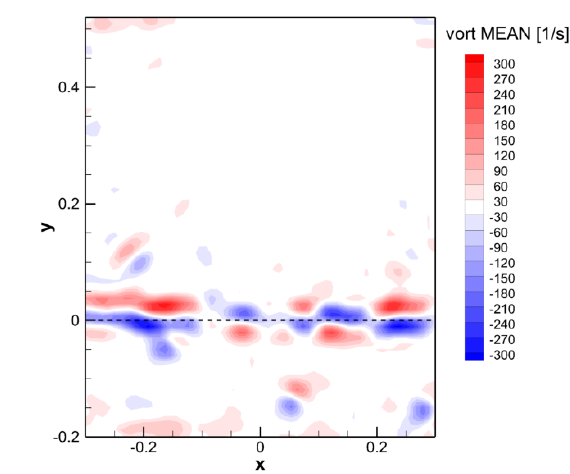
Fig. 14. Mean vorticity distribution. Re = 1M.